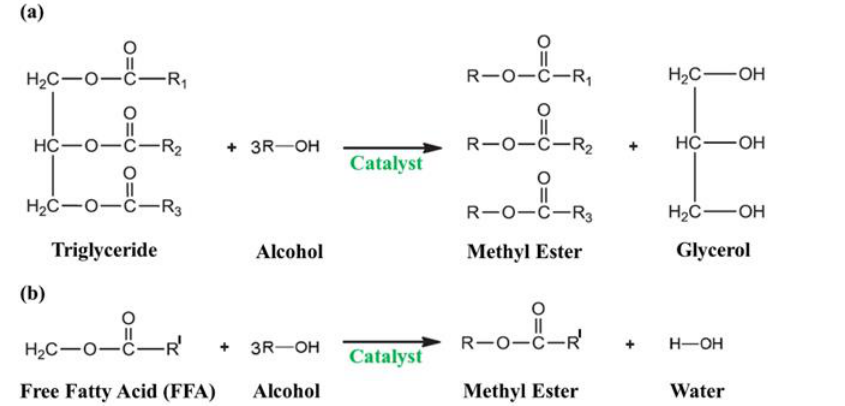
Fig. 1. (a) Transesterification reaction, and (b) esterification reaction for biodiesel